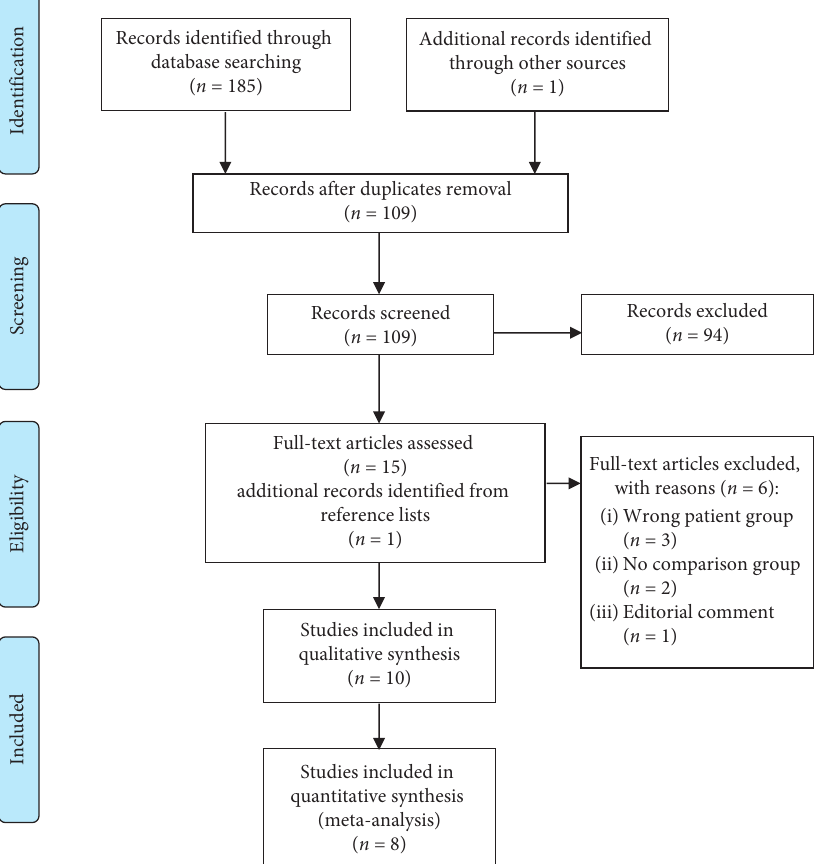
Figure 1: Flow diagram of study